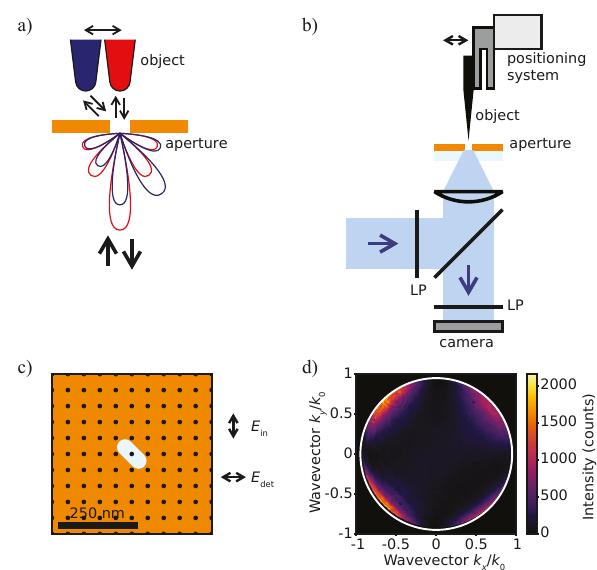
Figure 2: Experimental setup. (a) Minute changes in the near-field environment of an aperture influence its far-field radiation pattern. Monitoring the aperture’s radiation pattern enables the retrieval of the position of a nanoscale object. (b) Linearly polarized light is focused on the aperture using a microscope objective. Reflected light is collected through the same objective, filtered using a LP, and the cross-polarized signal is detected on a camera, which is imaging the back focal plane of the objective. A tapered optical fiber, positioned in the near field of the aperture using shear-force feedback, acts as the object. (c) Schematic of a near-field transducer containing a single aperture of 110 × 50 nm. The incident light is vertically polarized. The object is scanned across the aperture following a raster grid (black dots). (d) Measured cross-polarized radiation pattern of the